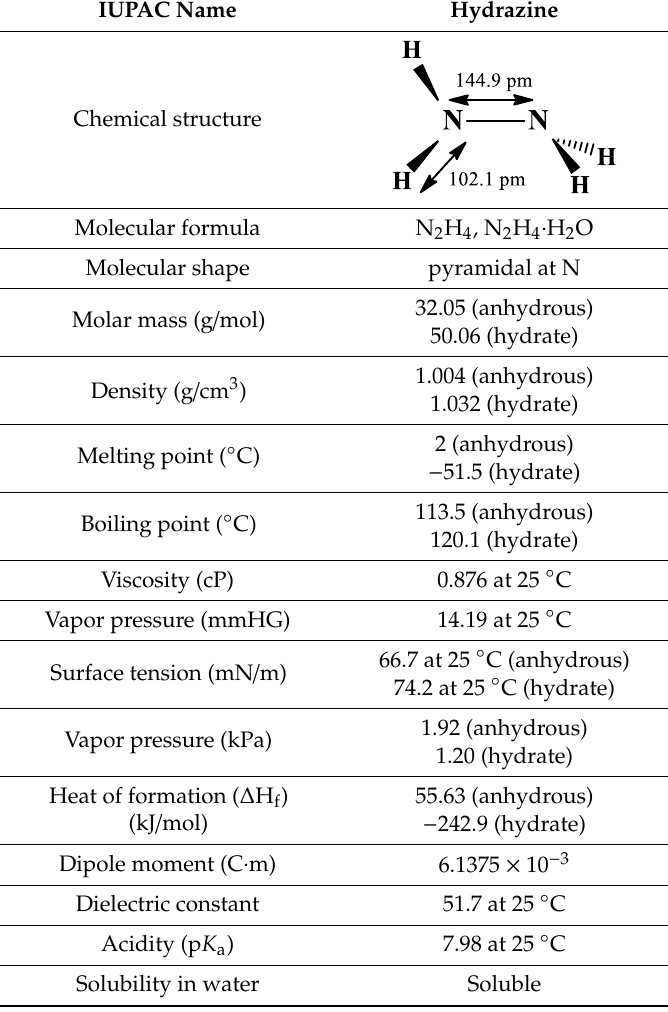
Table 1. Properties and chemical structure of hydrazine.